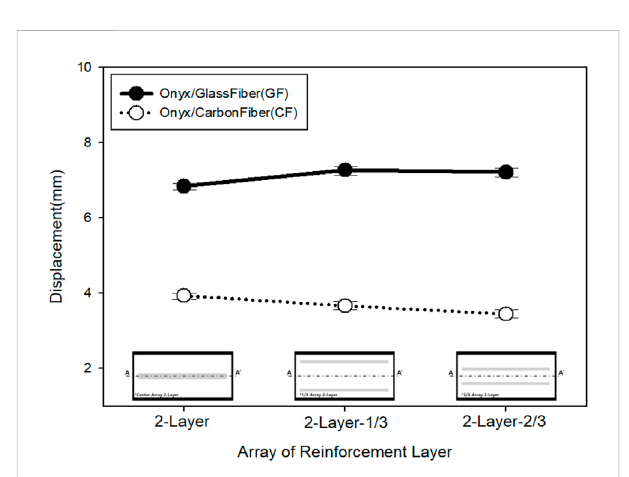
FIGURE 7 Specimen displacement according to the position of 2-layer